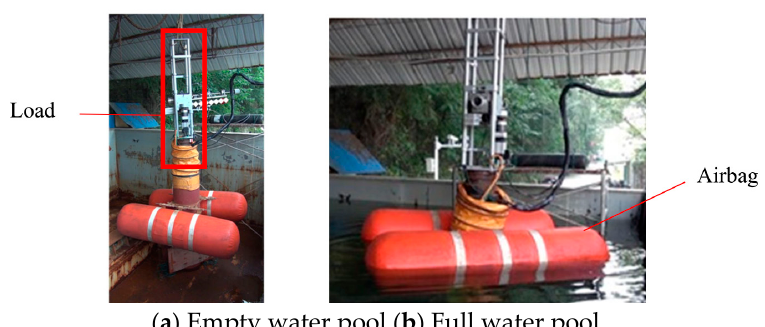
Figure 22. Floating platform setup for water surface stabilization experiment. The surface wave disturbance is exerted by the disturbance rope on both sides of the platform and the disturbance is generated manually via repeatedly pulling the rope. After the system is started, the slosh angle of about 0.4 Hz and ±10° is manually created, respec- tively. The obtained attitude stability curve is shown in Figure 23.